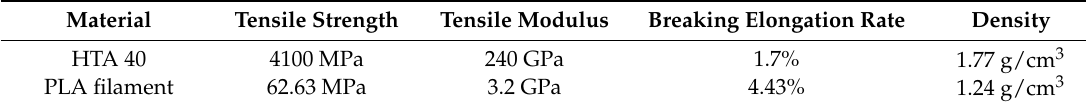
Table 1. Mechanical properties of HTA 40 and PLA.